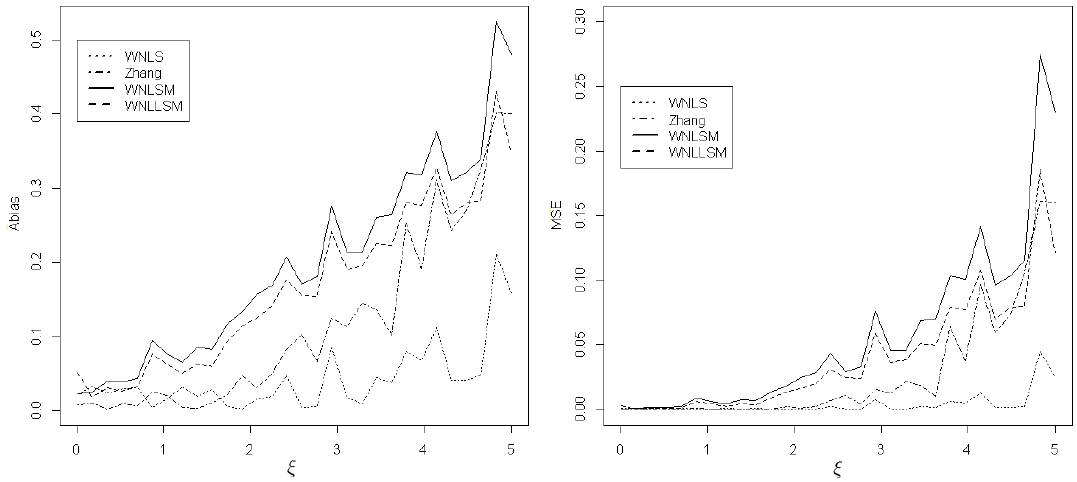
Figure 1. Absolute bias (Abias) and MSE of ξ for four estimators when µ = 0 and σ = 1.